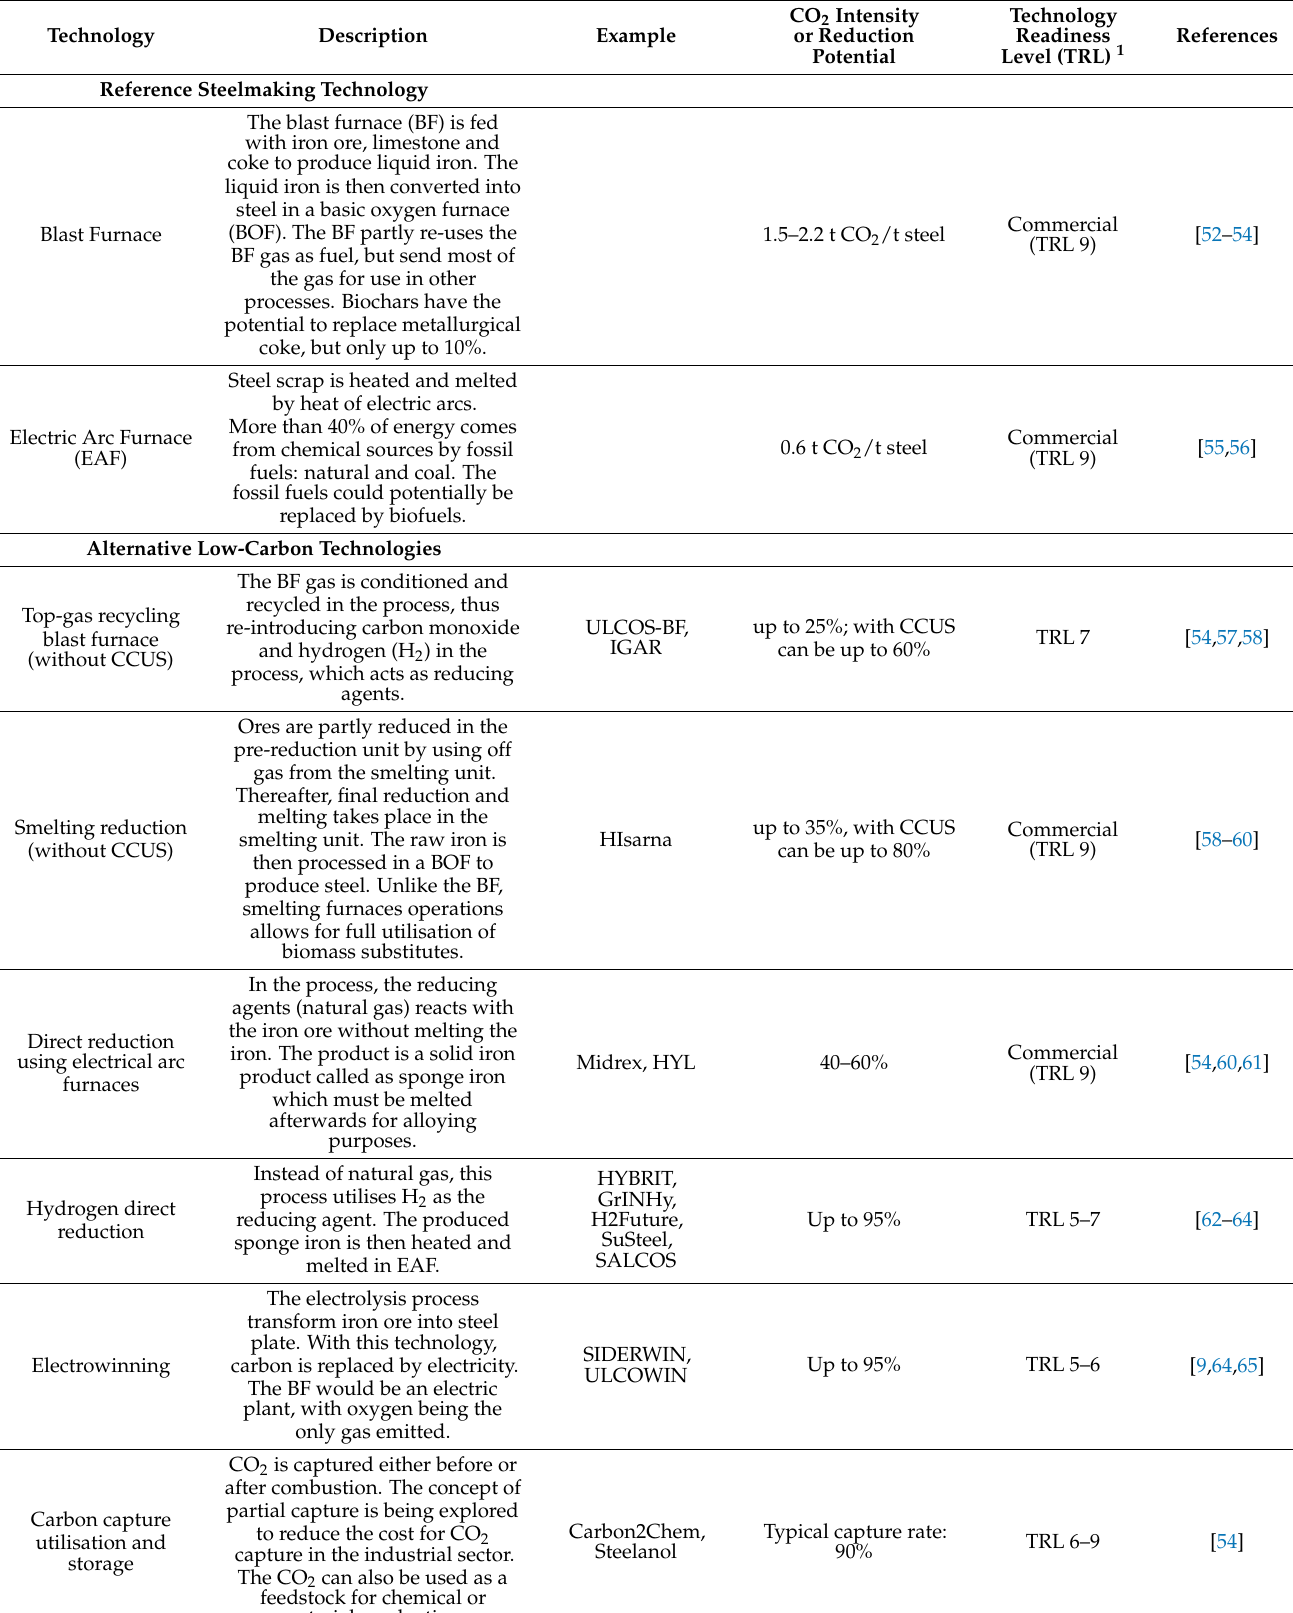
Table 1. Technical options for decarbonisation of iron and steel industry including CO 2 reduction potential and technology readiness levels (TRLs). See [49] for a description of the